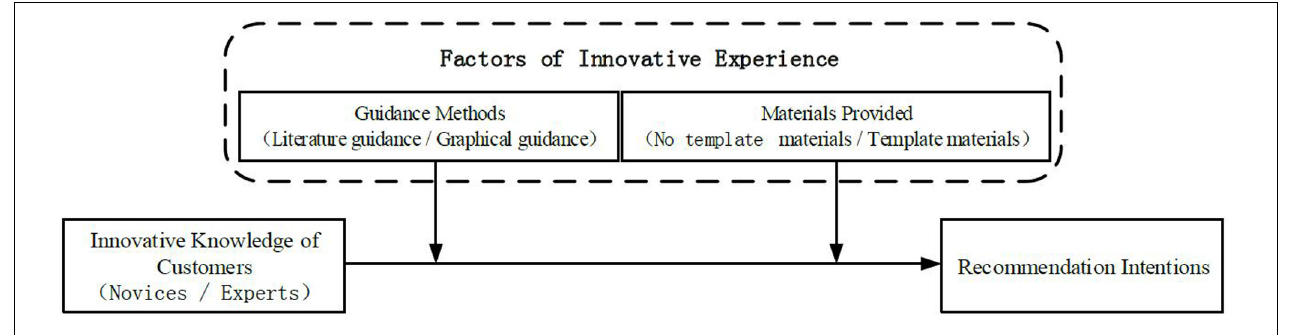
FIGURE 1 | Research Framework and hypothesized relationships.